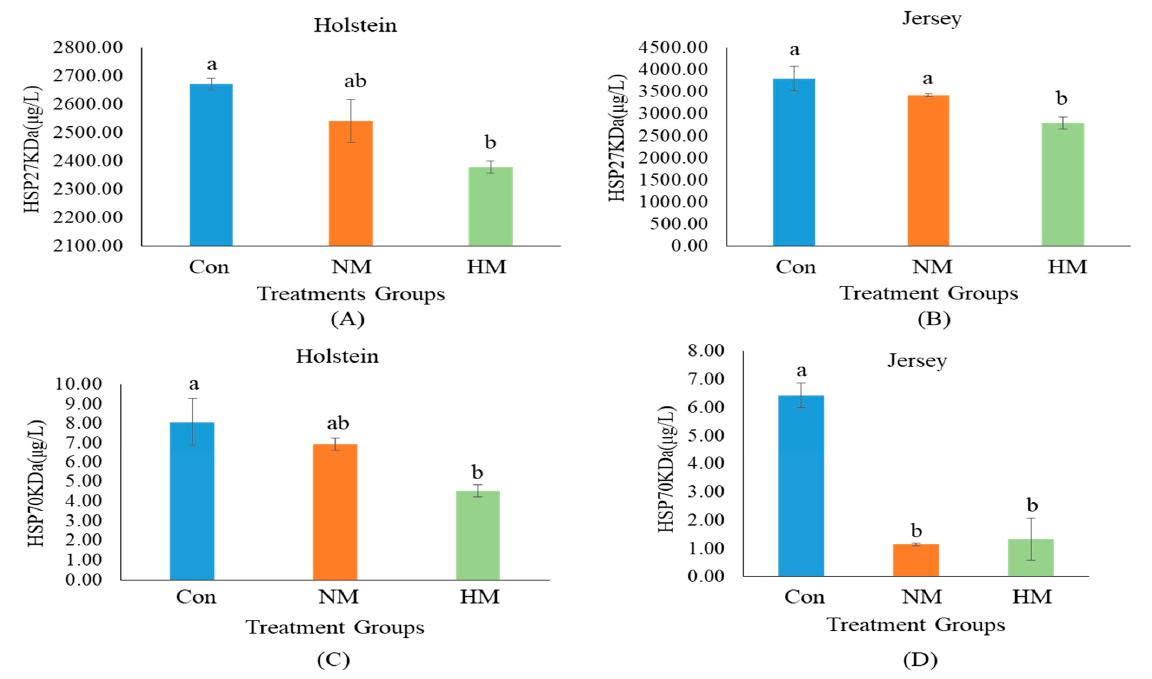
Figure 2. Serum concentrations of heat-shock proteins (HSPs) in Holstein ( A , C ) and Jersey steers ( B , D ) supplemented with different concentration of minerals. Con: only TMR (without mineral supplementation), NM: TMR + NRC recommended concentration of mineral supplementation (Se 0.1 ppm + Zn 30 ppm + Cu 10 ppm)/kg DM and HM: TMR + higher than recommended concentration of mineral supplementation (Se 3.5 ppm + Zn 350 ppm + Cu 28 ppm)/kg DM. The symbols a and b